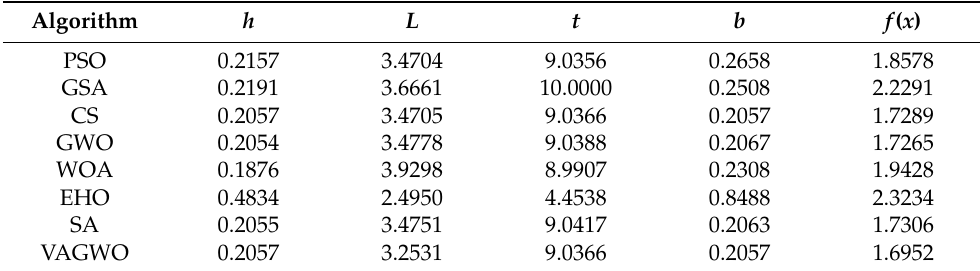
Table 16. Minimization results of welded beam design.